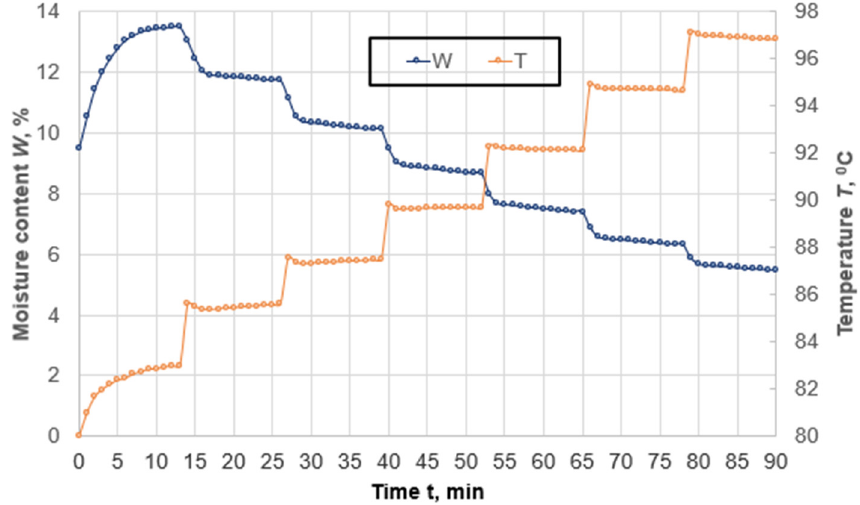
Figure 7. Change in average temperature and moisture content of compressed castor seed in a seven-stage heating kettle with vat bottom diameter of 1.58 m.